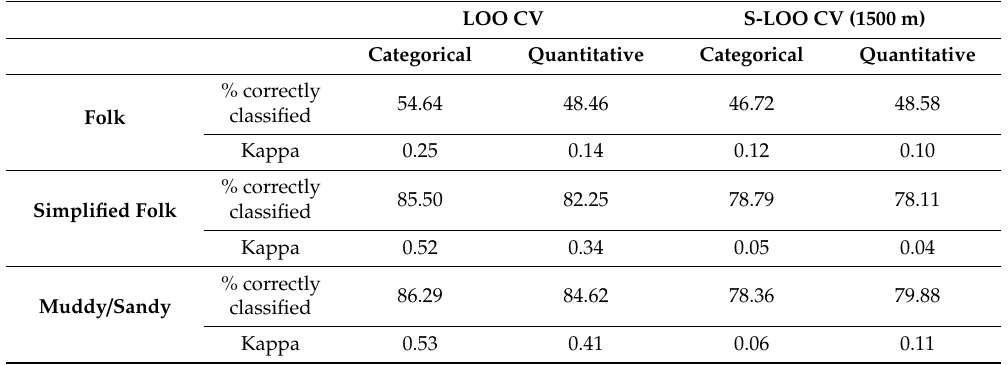
Table 4. Performance of quantitative and categorical grain size predictions using three schemes with spatial and non-spatial